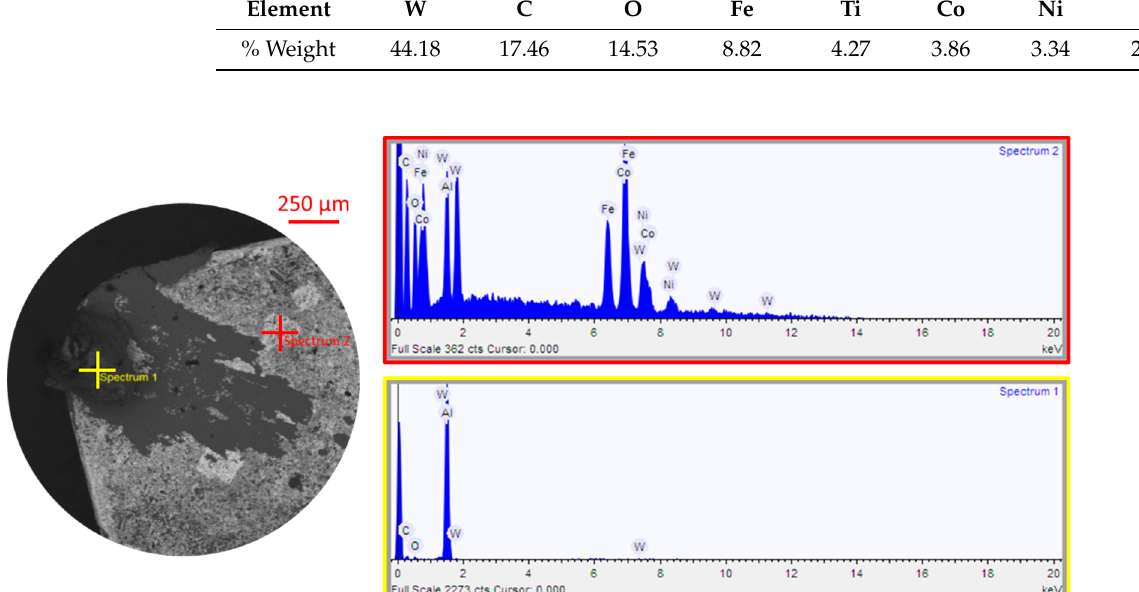
Figure 6. EDaX spectrum of the built-up edge (BUE) formation on coated tungsten carbide (WC) tool inserts. Table 5. Elemental composition of the red cross rectangular region in Figure 6.